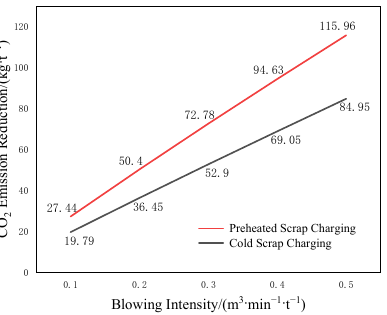
Figure 5. CO 2 emission reduction per ton of steel production by substituting argon bottom blowing with intense hydrogen bottom blowing.